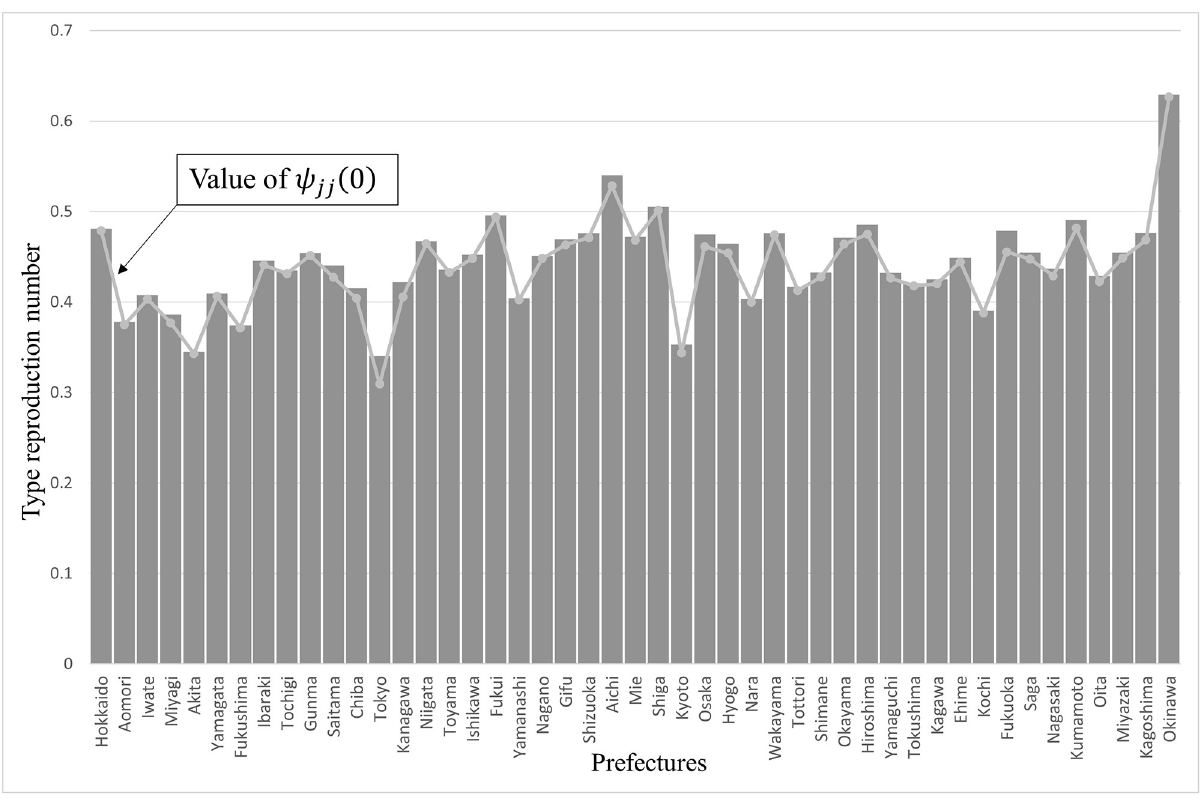
Fig 1. Type reproduction number in